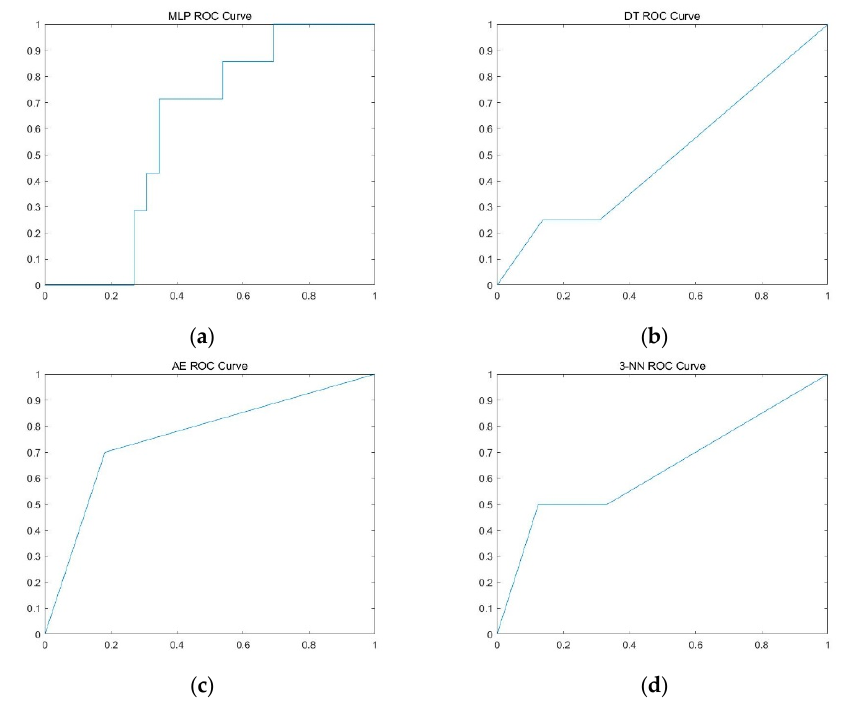
Figure 2. Receiver operating characteristic (ROC) curve using preoperative and postoperative parameters: ( a ) Multi-layer perceptron, ( b ) decision tree, ( c ) K-nearest neighbors (KNN), and ( d )